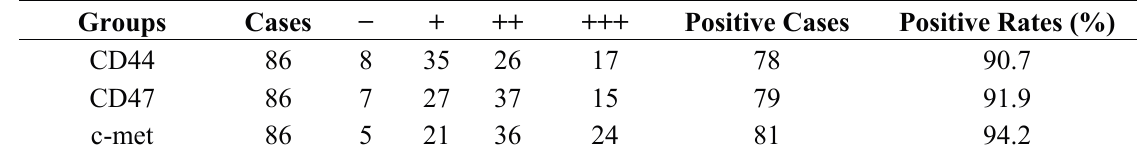
Table 1. Expression of CD44, CD47 and c-met in ovarian clear cell carcinoma (OCCC).